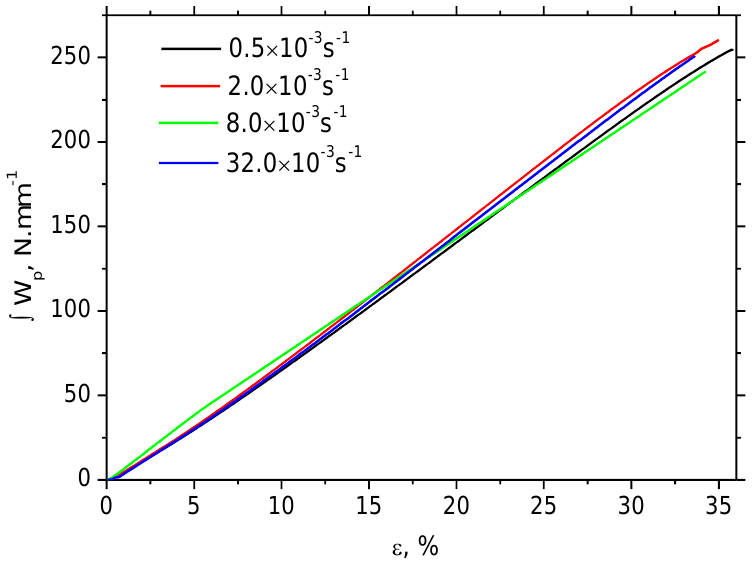
Figure 3. Evolution of plastic work W p as a function of plastic strain and strain rate.